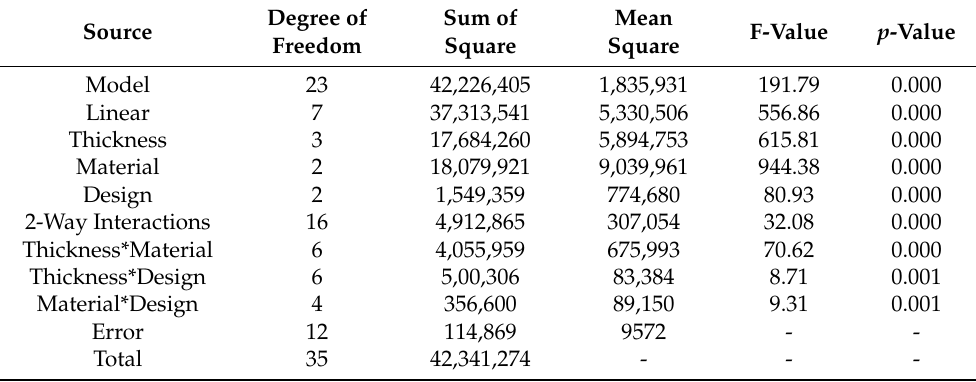
Table 6. ANOVA results for the stiffness performance